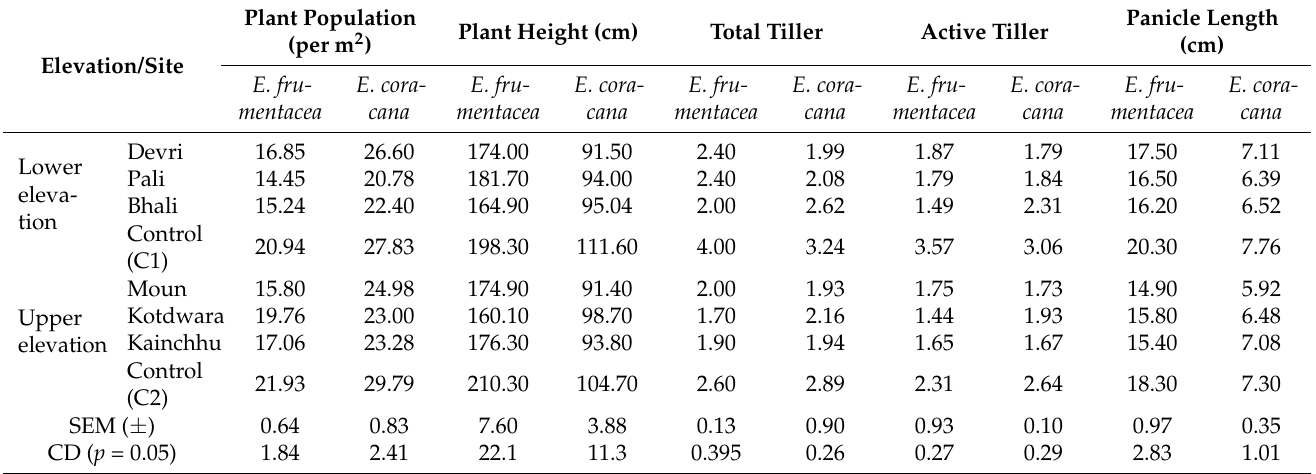
Table 3. Growth attributes of E. frumentacea and E. coracana under G. oppositifolia -based agrofores- try system.